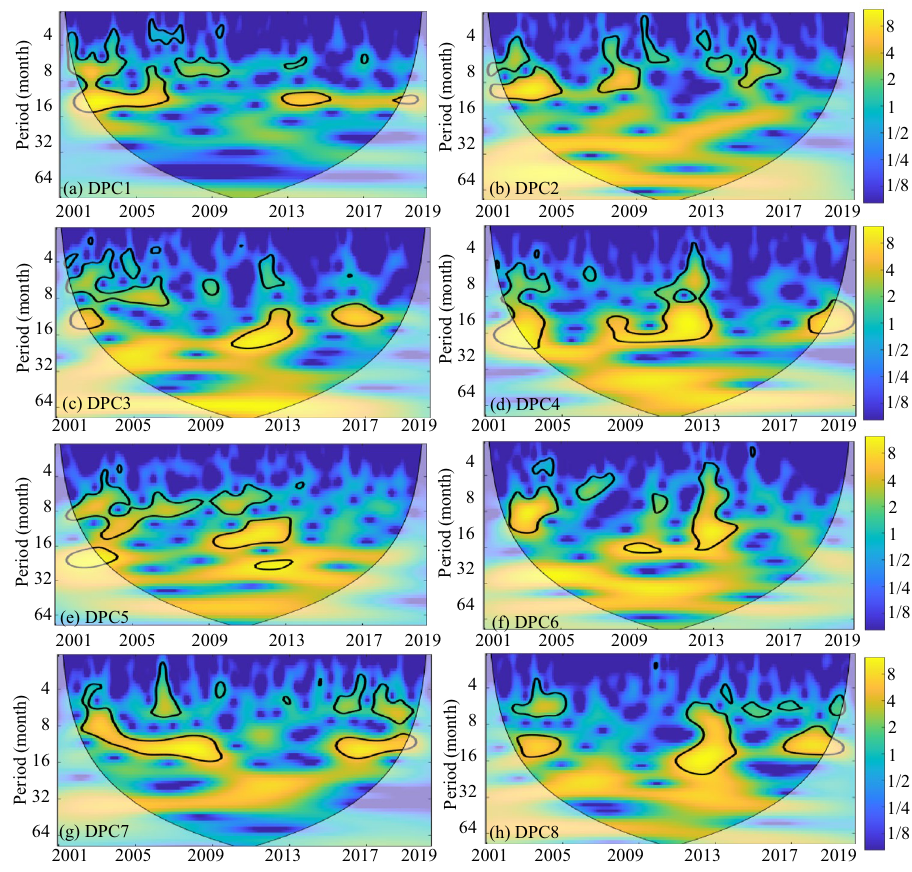
Figure 3. WPS of the DPC time series (Periodicity of time series). The black contour designates the 95% confidence level against red noise, and the COI, where edge effects might distort the picture, is shown as a lighter, paler shade. This figure was generated using MATLAB version R2020b (https:// jp. mathw orks. com/). The data used in the calculation comes from Fire CCI v5.1 dataset (https:// geogra. uah. es/ fire_ cci/ firec ci51. php).